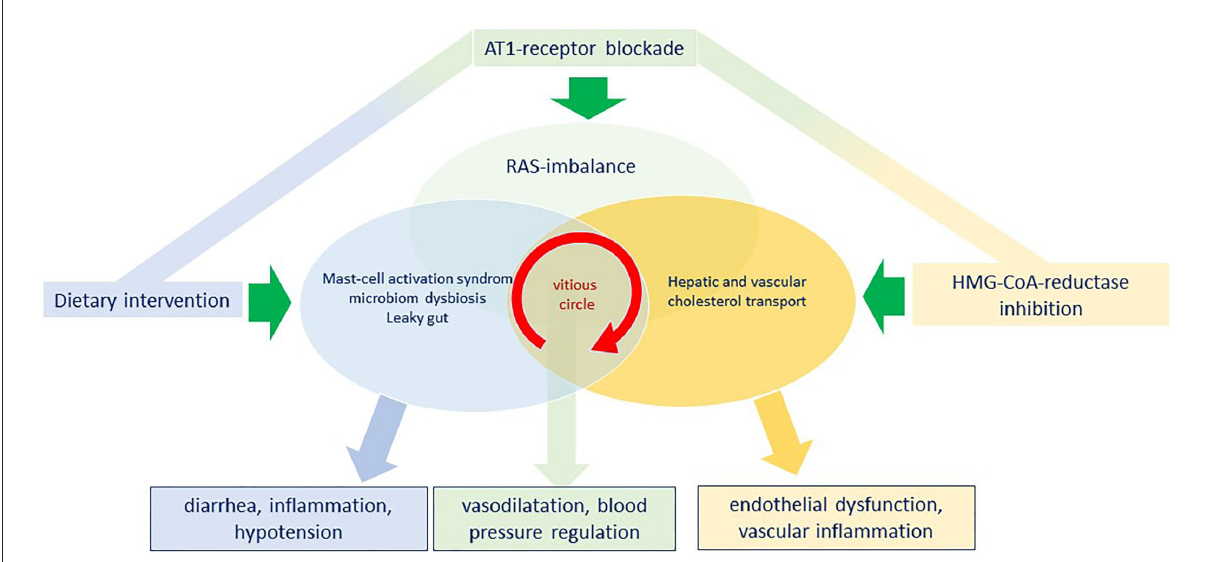
FIGURE4 Model for a simultaneous triple intervention with angiotensin II type 1 receptor blockade, HMG-CoA-reductase inhibition and dietary intervention to penetrate the vicious circle of the vascular interplay between a renin-angiotensin-system (RAS)-imbalance, a continuous mast-cell activation with a microbiome dysbiosis and to reconstitute vascular function and reduce